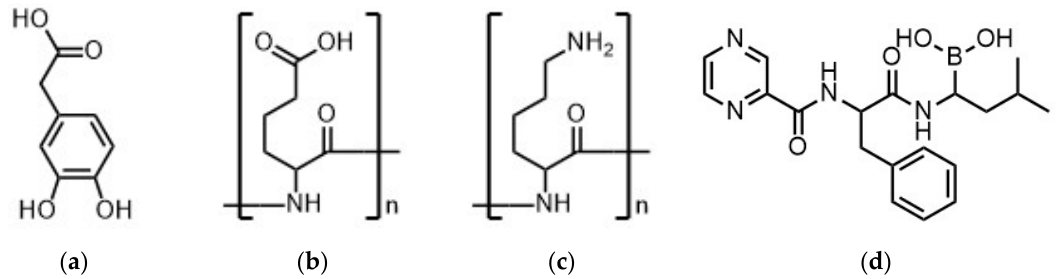
Figure 1. Chemical formulae of ( a ) 3,4-dihydroxyphenylacetic acid (DOPAC); ( b ) poly( L -glutamic acid) (PLG); ( c ) poly( L -lysine) (PLL); and ( d ) bortezomib (BZM).